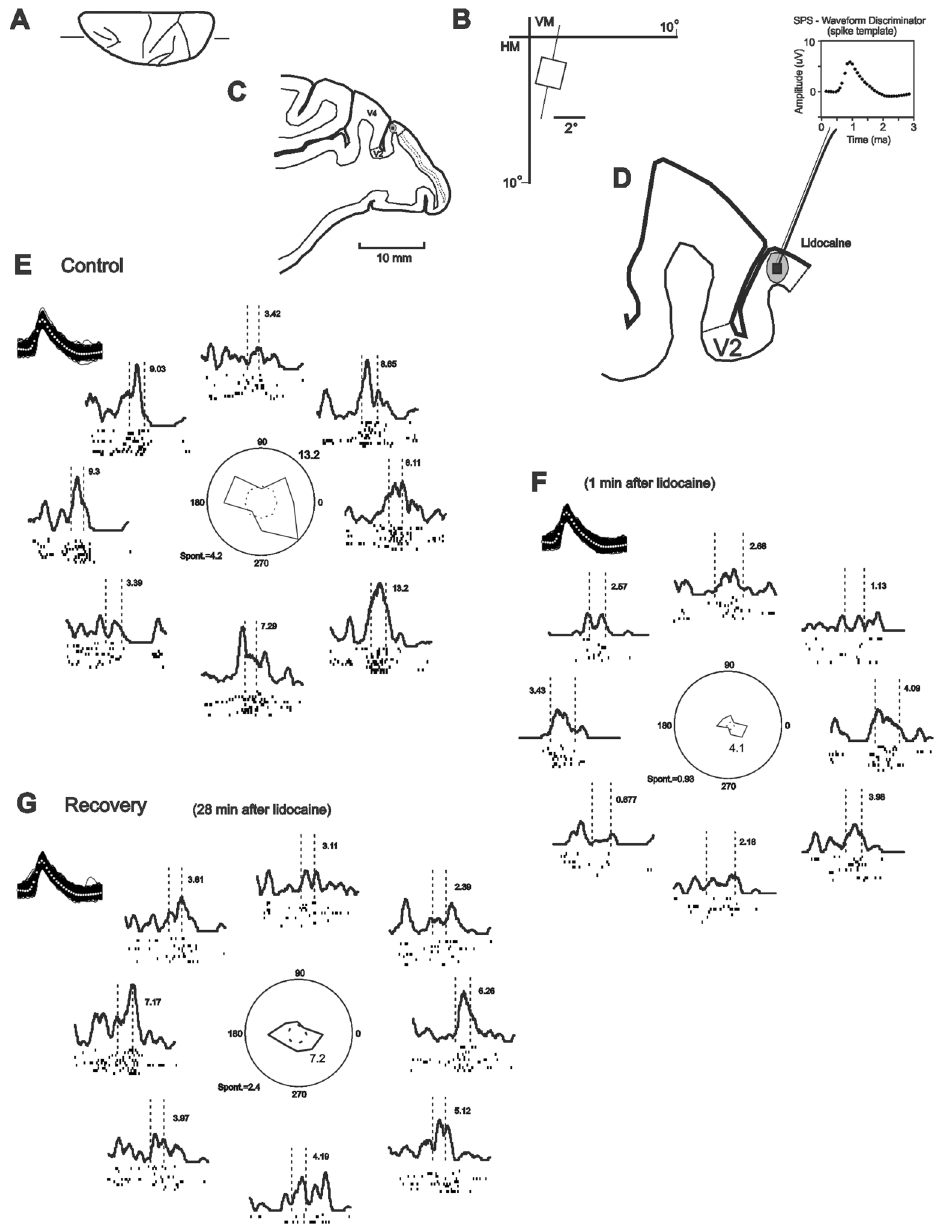
Figure 4. Effect of a large 2% lidocaine injection (6 m L) on the intrinsic circuit of V2. A , Dorsal reconstruction of the Cebus brain, indicating the levels of the section illustrated in C . B , Visual field location of the receptive fields of V2 that were studied in this experiment. The small square in B corresponds to the V2 receptive field. HM: horizontal meridian: VM: vertical meridian. D , Enlarged portion of the parasagittal sections showing the location of inactivation and of the recording site in V2 (inset: SPS-8701: waveform discriminator spike template). E , The polargrams illustrate the V2 neuron mean firing rate elicited by bars moving in 8 directions orthogonal to the axis of movement (control condition, polargram at the top). Left inset: superimposed spike waveforms (black solid lines) and spike template (white dots). Spike density function and 10 trials spike rasters are illustrated for each direction. F , One minute after lidocaine inactivation. The loss of unidirection selectivity of a V2 neuron after a 2% lidocaine inactivation of area V2 (P , 0.05, one- way ANOVA). G , Twenty-eight minutes after lidocaine